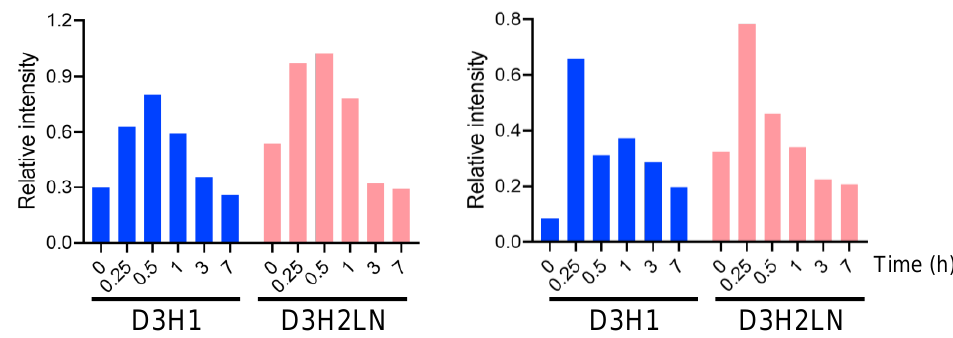
Figure 4. Biological activities of DG accumulated in EVs. ( A ) Microscopic images of HUVECs uptaking fluorescent-labeled EVs. HUVECs were imaged after 7 h from supplementing D3H1 or D3H2LN EVs labeled with green fluorescent dye, PKH67. PBS without EVs that underwent the same fluorescent labeling procedure was supplemented for negative control. Nuclei were labeled with DAPI (shown in magenta). Scale bar: 50 µ m. ( B ) (Top) Immunoblot of time-course phosphorylation of PKD / PKC µ in HUVECs after D3H1 or D3H2LN EVs were supplemented. Tubulin was detected as a loading control. (Bottom) Quantification of the intensity of immunoblot bands normalized with that of tubulin.